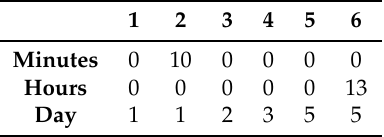
Figure 9. This figure shows the photovoltaics (PV) production on 12 June 2019. The forecast shown is based on the model in Table 4. Table 4. 6 decision variables of the forecast model of PV production in the optimized case.